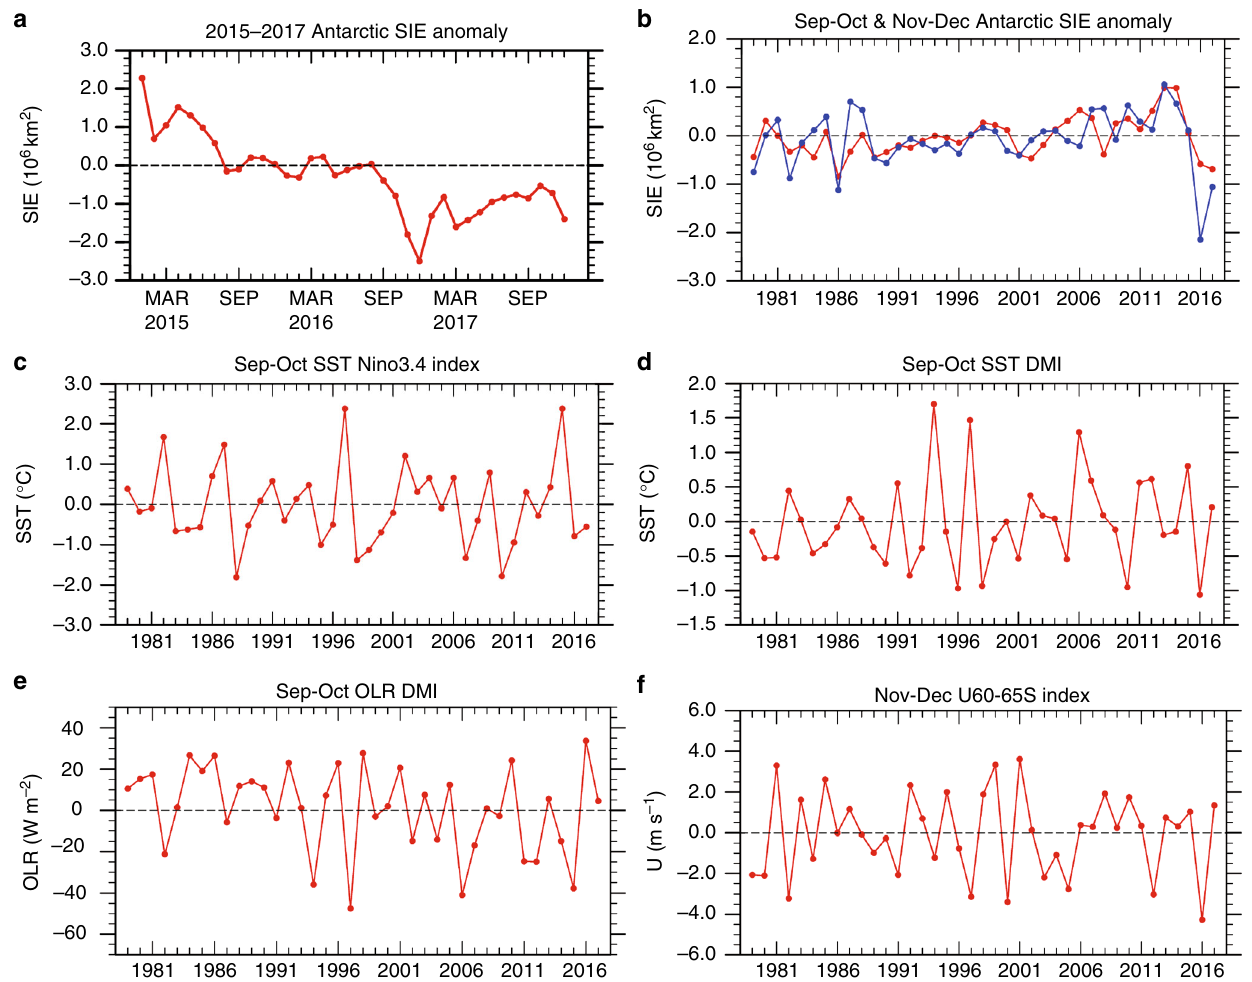
Fig. 1 Observed indices of Antarctic sea-ice and several key climate drivers during austral spring 1979 – 2017. a Monthly anomaly during 2015 – 2017 of Antarctic sea-ice extent (SIE) (10 6 km 2 ). The same time series for full period 1979 – 2017 is shown in Supplementary Figure 1. b SIE anomaly (10 6 km 2 ) for September – October (Sep – Oct, red curve) and November – December (Nov – Dec, blue curve); c Sep – Oct SST Niño3.4 index (°C); d Sep – Oct Indian Ocean Dipole Mode index for SST, denoted as SST Dipole Mode Index (SST-DMI, °C); e same as d but the index is calculated using the anomalous OLR, denoted as OLR-DMI (W m − 2 ); f Nov – Dec zonal wind index U 60 – 65S (m s − 1 ). All anomalies are deviations relative to 1979 – 2015 means. Other details see Methods. Plots were generated using the NCAR Command Language version 6.4.0